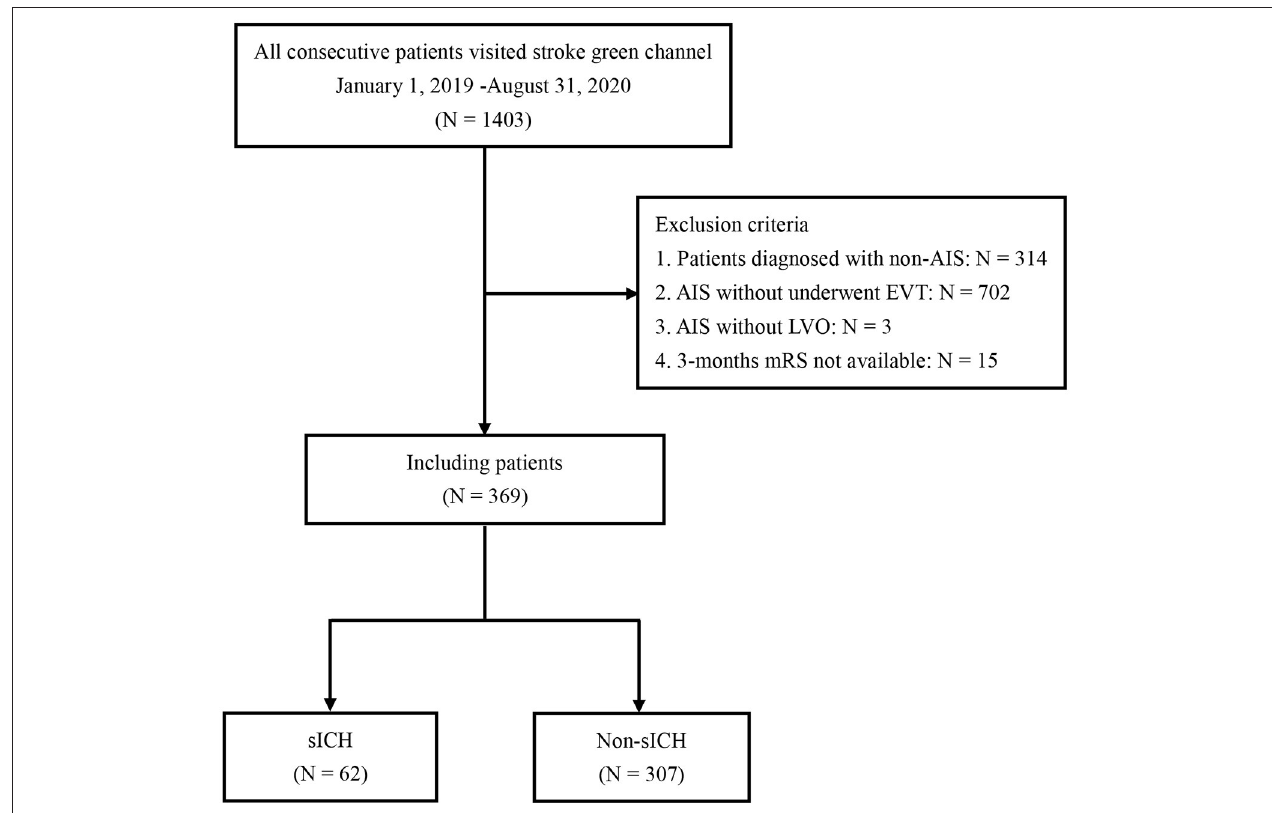
FIGURE 1 | Flowchart of patient selection. AIS, acute ischemic stroke; LVO, large vessel occlusion; EVT, endovascular treatment; sICH, symptomatic intracranial